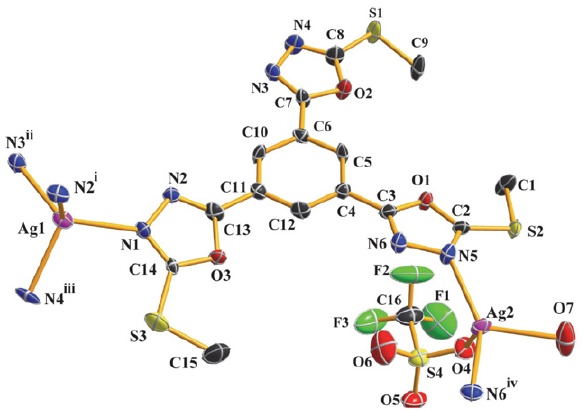
Figure 2. The coordination environment of Ag + in 1 at 50% proba- bility displacement. (Solvent molecules are omitted for clarity) Symmetry codes: (i) -y+7/4, x+1/4, z+1/4; (ii) -x+3/2, -y+2, z+1/2; (iii) y-1/4, -x+7/4, z+3/4; (iv) -y+7/4, x+1/4, z-3/4.